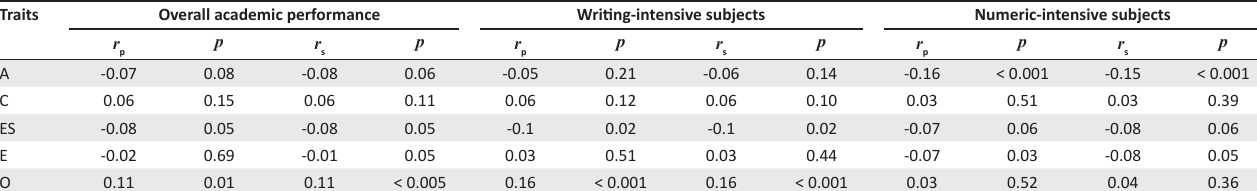
TABLE 2: Correlation between five-factor model trait scores and academic performance. Traits